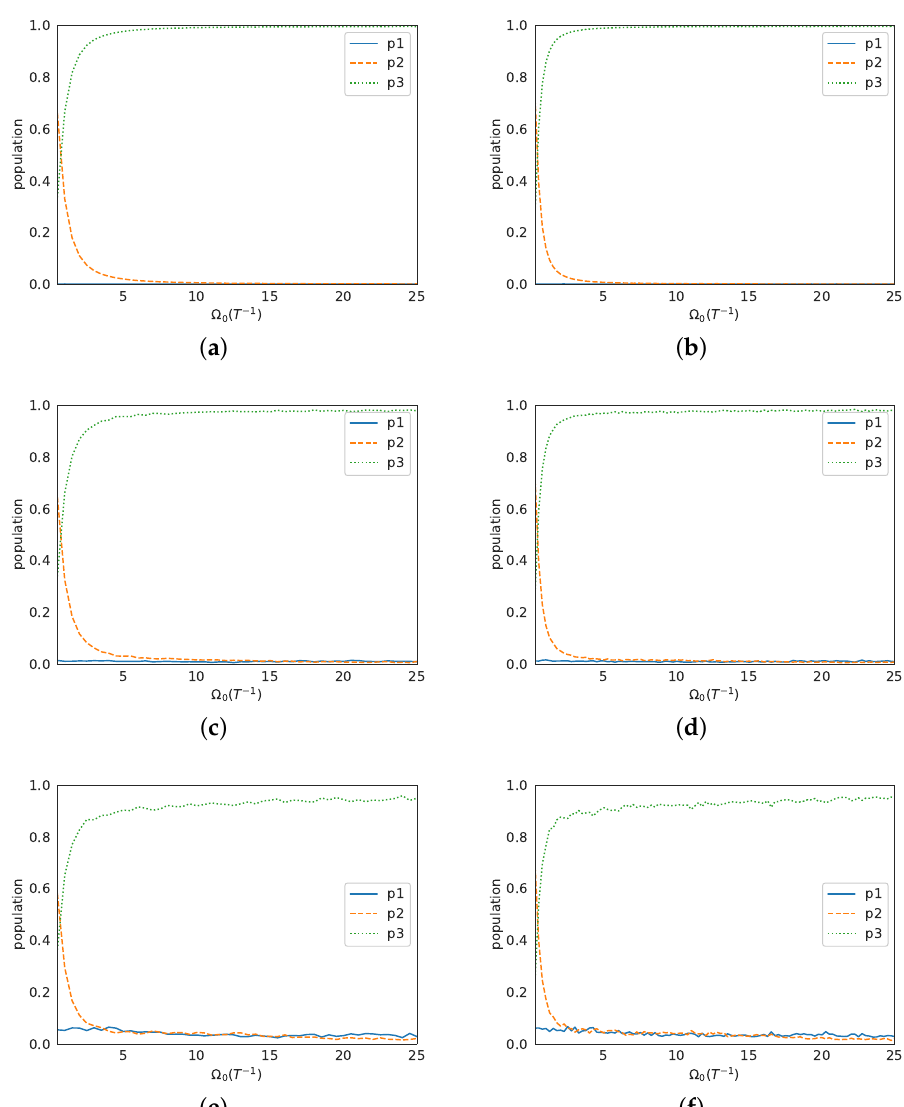
Figure 7. Final populations p i ( T ) , i = 1,2,3, as functions of parameter Ω 0 , for the STIRAP shortcuts derived from Gaussian pulses. In ( a , c , e ) standard shortcut has been used and in ( b , d , f ) the modified shortcut has been used. The three rows correspond to three different values of the noise correlation time, τ c / T = 0.008,0.08,0.8, respectively, while the standard deviation is set to σ n = 5 T − 1